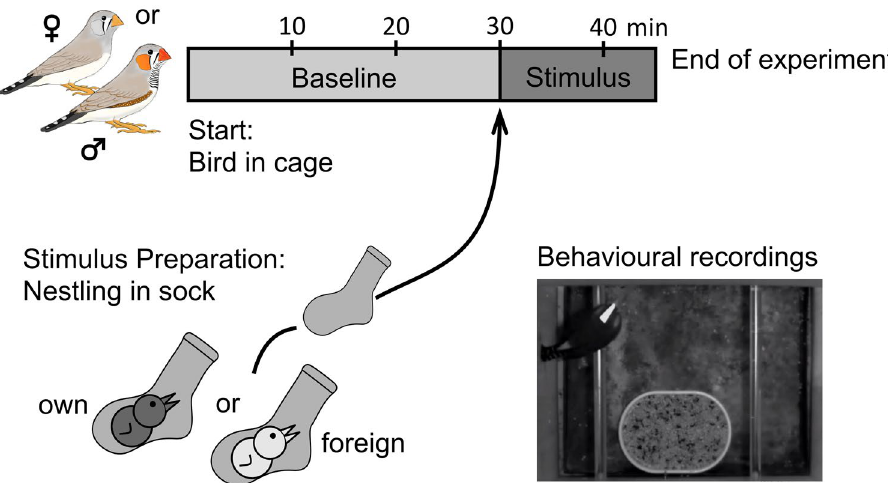
Figure 1. Experimental procedure. At the start of the experiment, test subjects, i.e. either the male or the female, were equipped with an arrow shaped reflectance foil attached to the scalp feathers and were put into the experimental cage. Birds habituated to the test environment for 30 min. Video recordings were taken immediately after the test subjects were put into the cage until 15 min after the stimulus odour was presented, i.e. in total for 45 min. During the time of habituation, i.e. during the first 30 min, we prepared the odour stimuli by putting an own nestling or a foreign nestling into a sock for 30 min. After 30 min the chick was moved to its natal nest and the sock was used as an odour stimulus. For both, baseline and stimulus, we counted the mean number of head saccades within ten consecutive intervals of one minute each and averaged these ten counts to obtain an average number of head saccades per